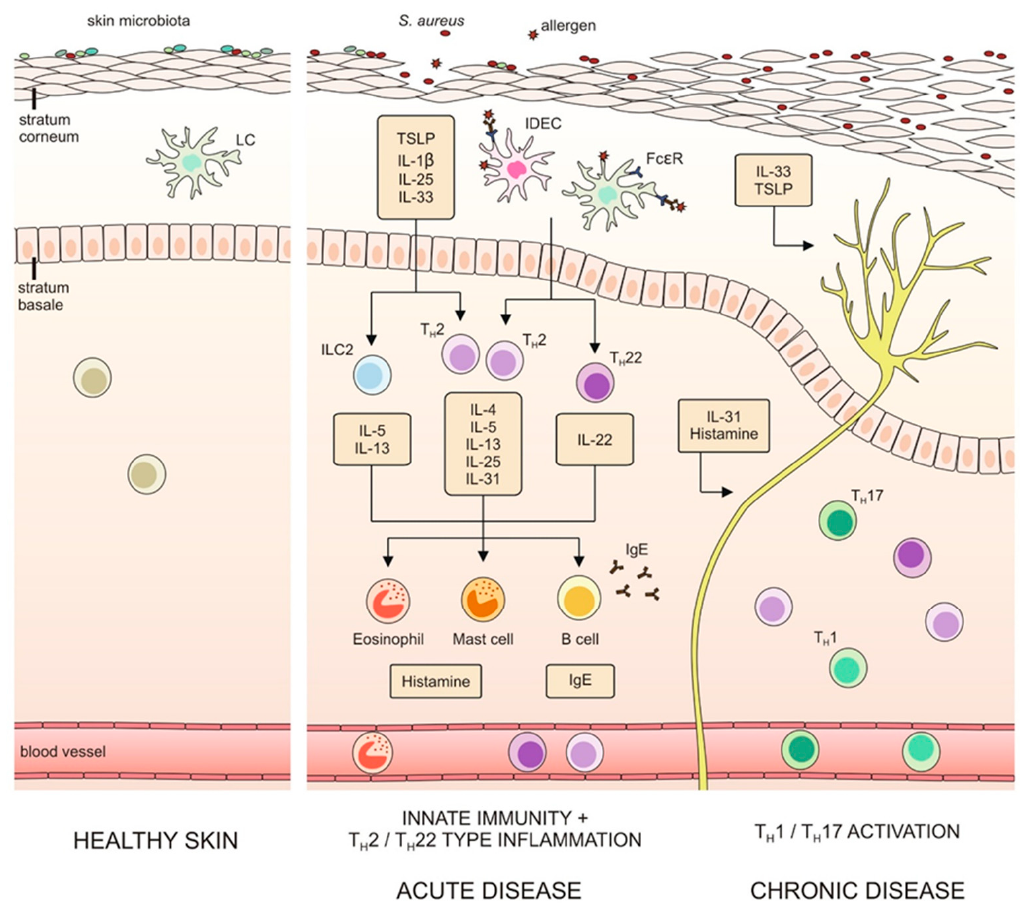
Figure 2. Epithelial barrier dysfunction, immune dysregulation and skin microbiota dysbiosis in initiation and progression of AD. Epithelial barrier dysfunction and stress from environmental and mechanical factors lead to skin barrier damage and enhanced epidermal permeability, which in turn increases microbial and allergen contact with the cutaneous immune system. Damaged keratinocytes activate immune mechanisms by releasing proinflammatory cytokines (IL-1 β , TSLP, IL-25, IL-33) and chemokines, mobilizing innate lymphocyte subsets and skin-resident dendritic cells (DCs). DCs attract and prime naive T-cells, promoting T H 2/T H 22 cell responses and inducing inflammation process. Type 2 cytokines (IL-4, IL-5, IL-13, IL-25) drive the inflammation, recruiting and activating other types of immune cells, such as eosinophils, mast cells and B-cells. The secreted molecules and proinflammatory cytokines act directly on cutaneous nerves and contribute to pruritus. Moreover, the inflammation further disrupts skin barrier and favors colonization by pathogens ( S. aureus ), additionally inducing keratinocyte damage and boosting T H 2-type response, thus supporting the disease cycle. The activation of T H 1/T H 17 cell responses in chronic disease induce tissue remodeling, increasing skin thickness and lichenification. IDEC—inflammatory dendritic epidermal cell, ILC2— group 2 innate lymphoid cell, LC—Langerhans cell, T H 1—T H 1 cell, T H 2—T H 2 cell, T H 17—T H 17 cell, T H 22—T H 22